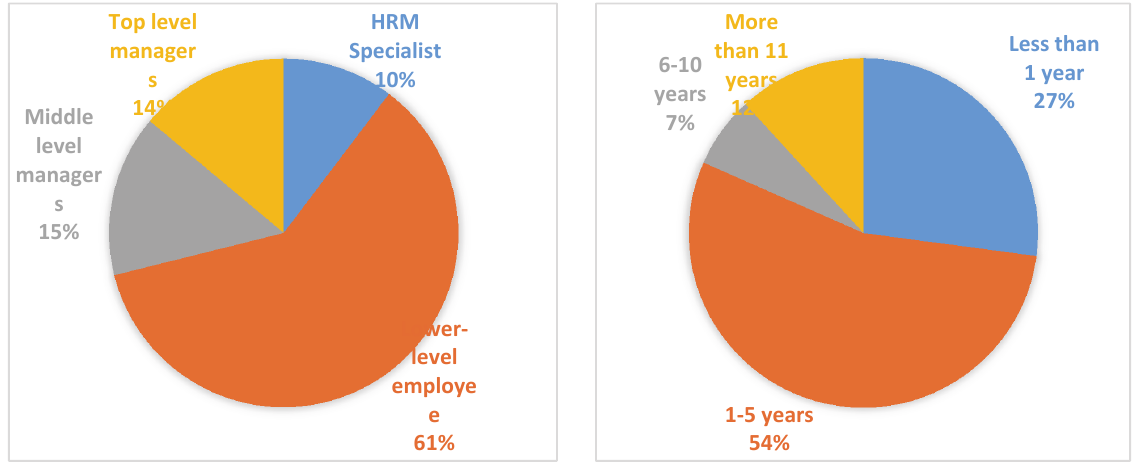
Fig. 6. Position at work distribution chart Fig. 7. Tenure distribution